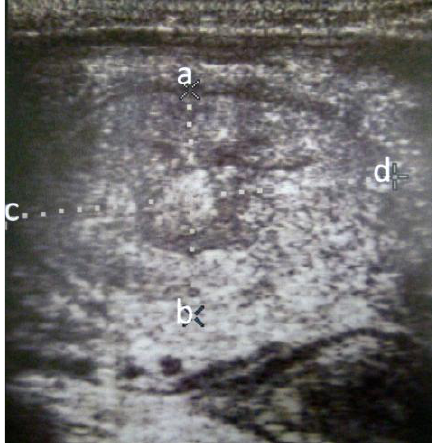
Figure 1. Ultrasonogram of endometria in dairy cows. Diameters and areas of the endometria at the base of each uterine horn (approximately 5 cm anterior the uterine body) were measured and recorded by cross-sectional images. Note: If the structure of the scanned images was not spherical, the diameters of two 90  dimensions (a spot to b spot is the minor axis, c spot to d spot is the major axis) of uterine horns were averaged to obtain the values of